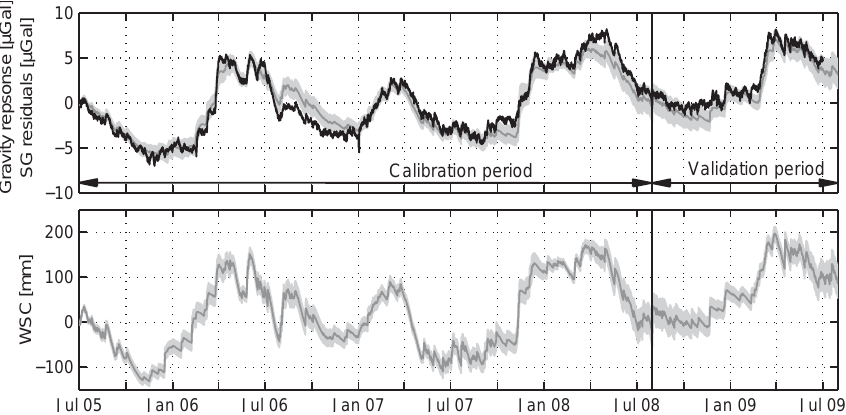
Fig. 8. SG residuals (black line) and modelled gravity response (grey band) (top). Modelled water storage change (bottom). The model was calibrated against the SG residuals for the period of 1 July 2005 to 30 July 2008.